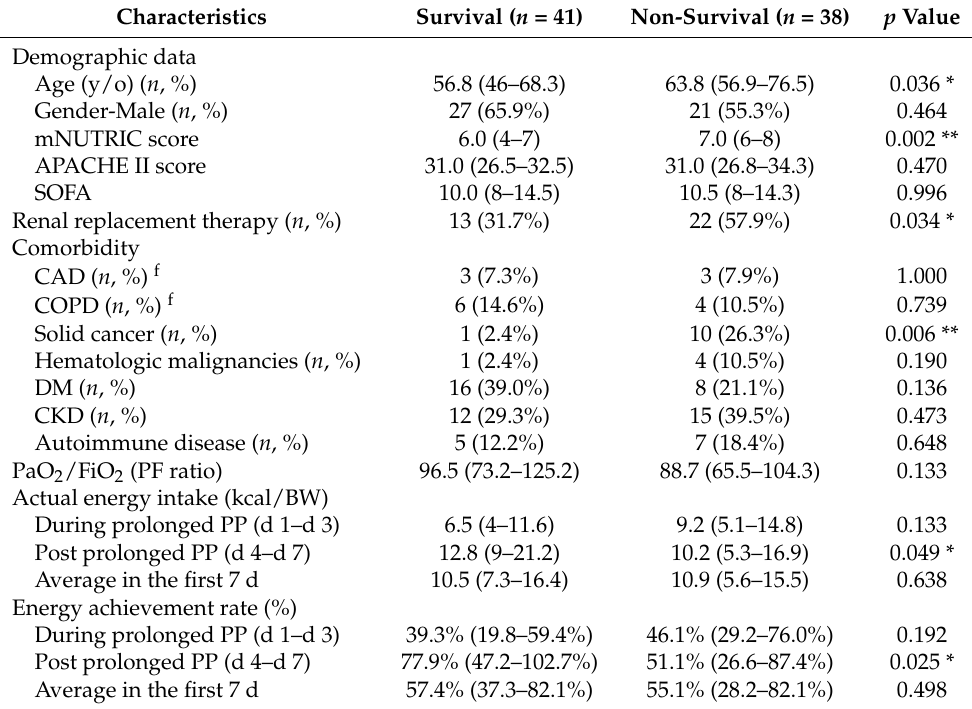
Table 2. Demographic characteristics, severity index, comorbidities, and EAR in survival and non- survival